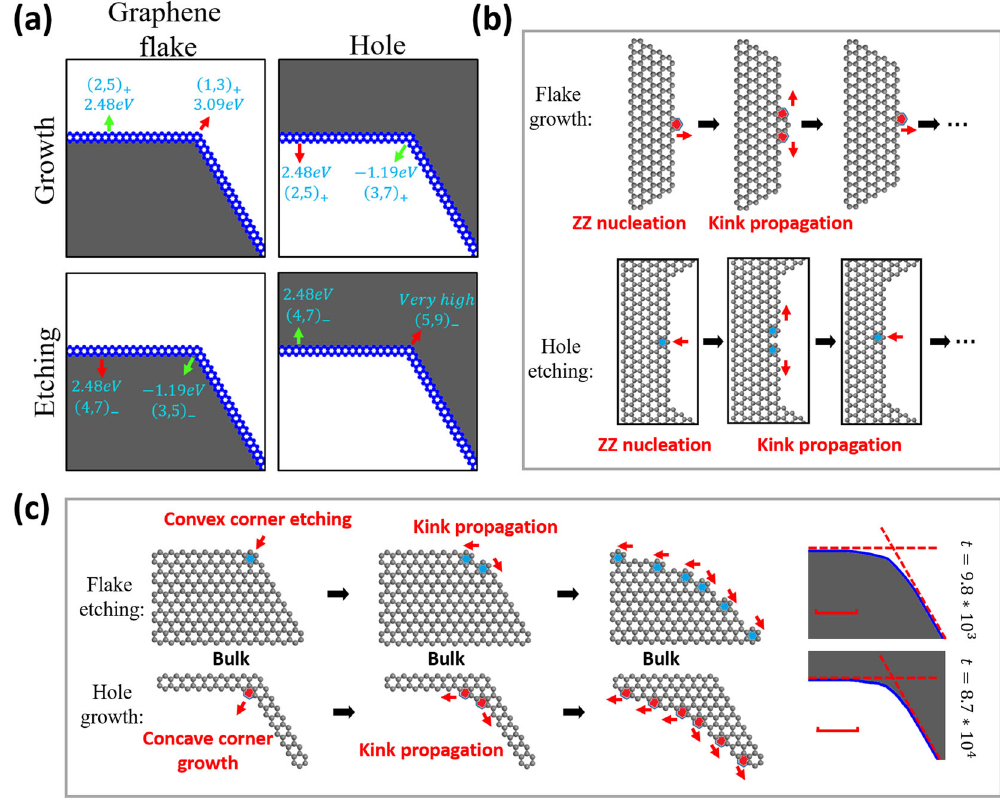
Fig. 6 Schematic illustration of the mechanism of the growth and etching of graphene island and hole, respectively. a Geometric structure of corners of graphene island and hole and the reaction energies of corresponding events during growth and etching. The events pointed by green arrows are energetically more favorable than those pointed by red arrows. b Similarity between graphene island growth and hole etching. c Similarity between graphene island etching and hole growth, and two snapshots taken from KMC simulations of island etching and hole growth, the scale bars are 1 μ m and 150 nm,